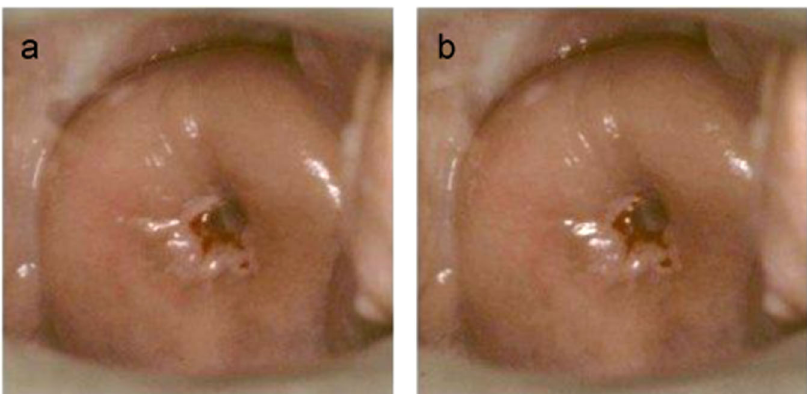
Fig. 1 Illustration of repeatability issues from deep learning models on different images of a cervix with precancerous lesions from the same patient taken the same day. A binary model without dropout layers generated the following outputs. ( a ) Model prediction: 0.01 (Normal): The binary model predicts a normal cervix (severity score: 0.01). ( b ) Model prediction: 0.98 (Pre-cancer): The binary model predicts pre-cancer (severity score: